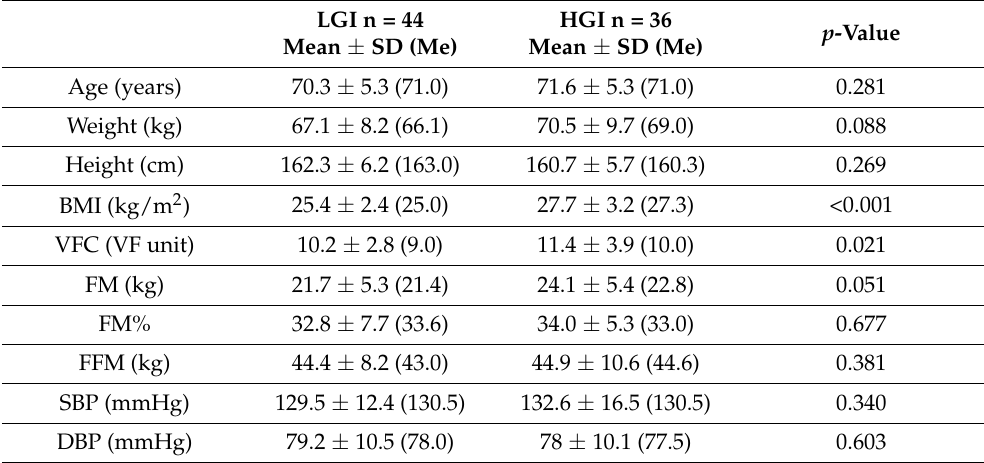
Table 1. Basic characteristics of study